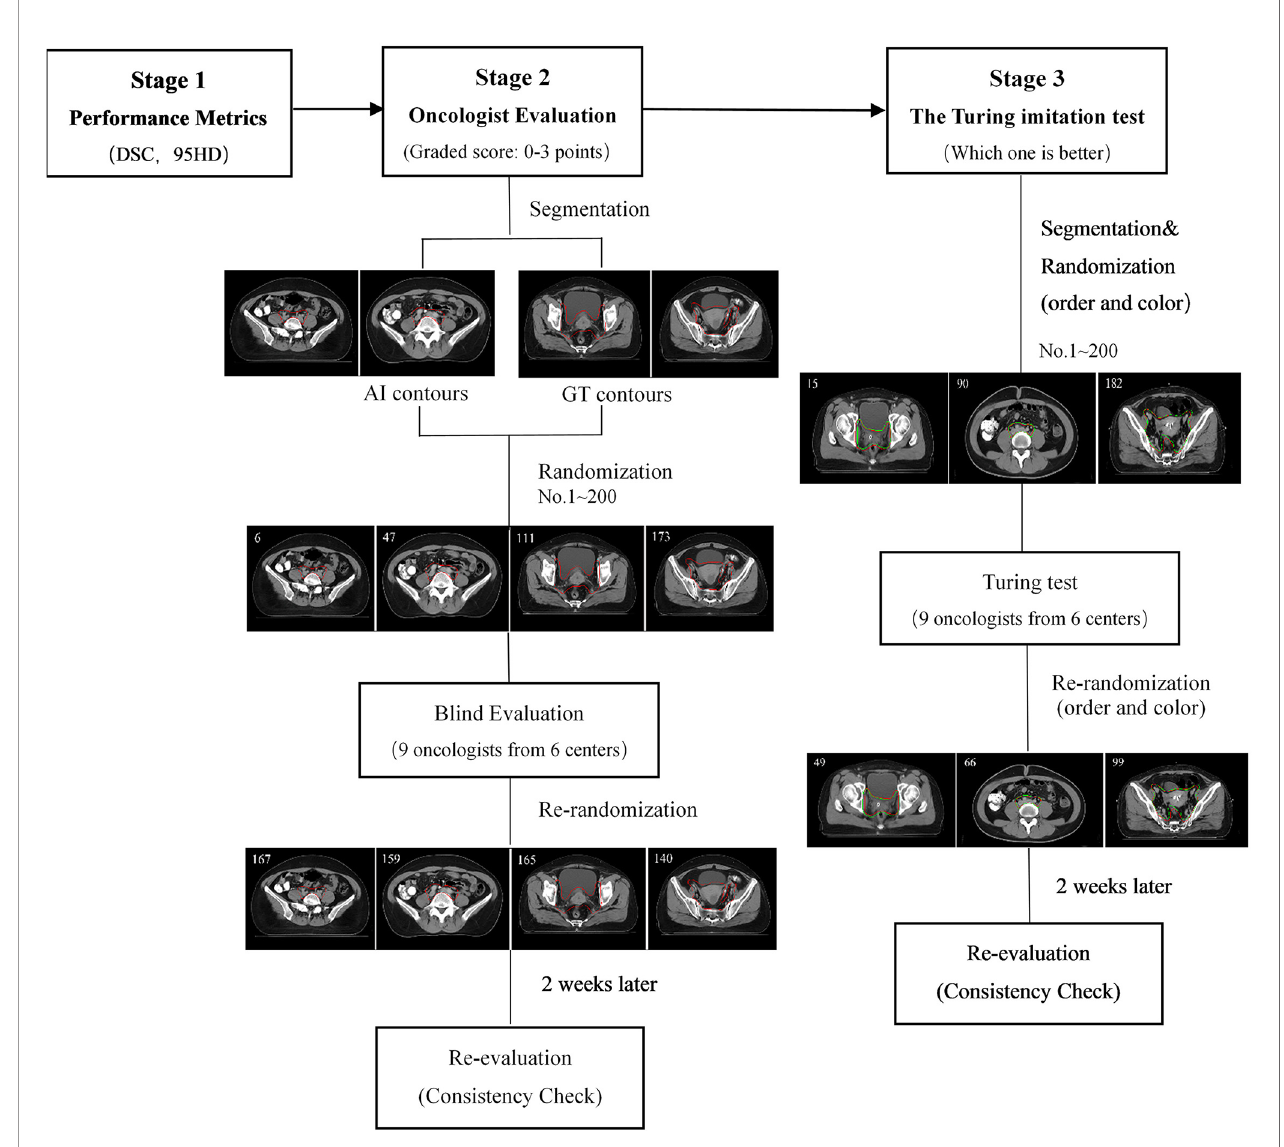
FIGURE 2 | The fl owchart of the three-stage multicenter randomized controlled evaluation.